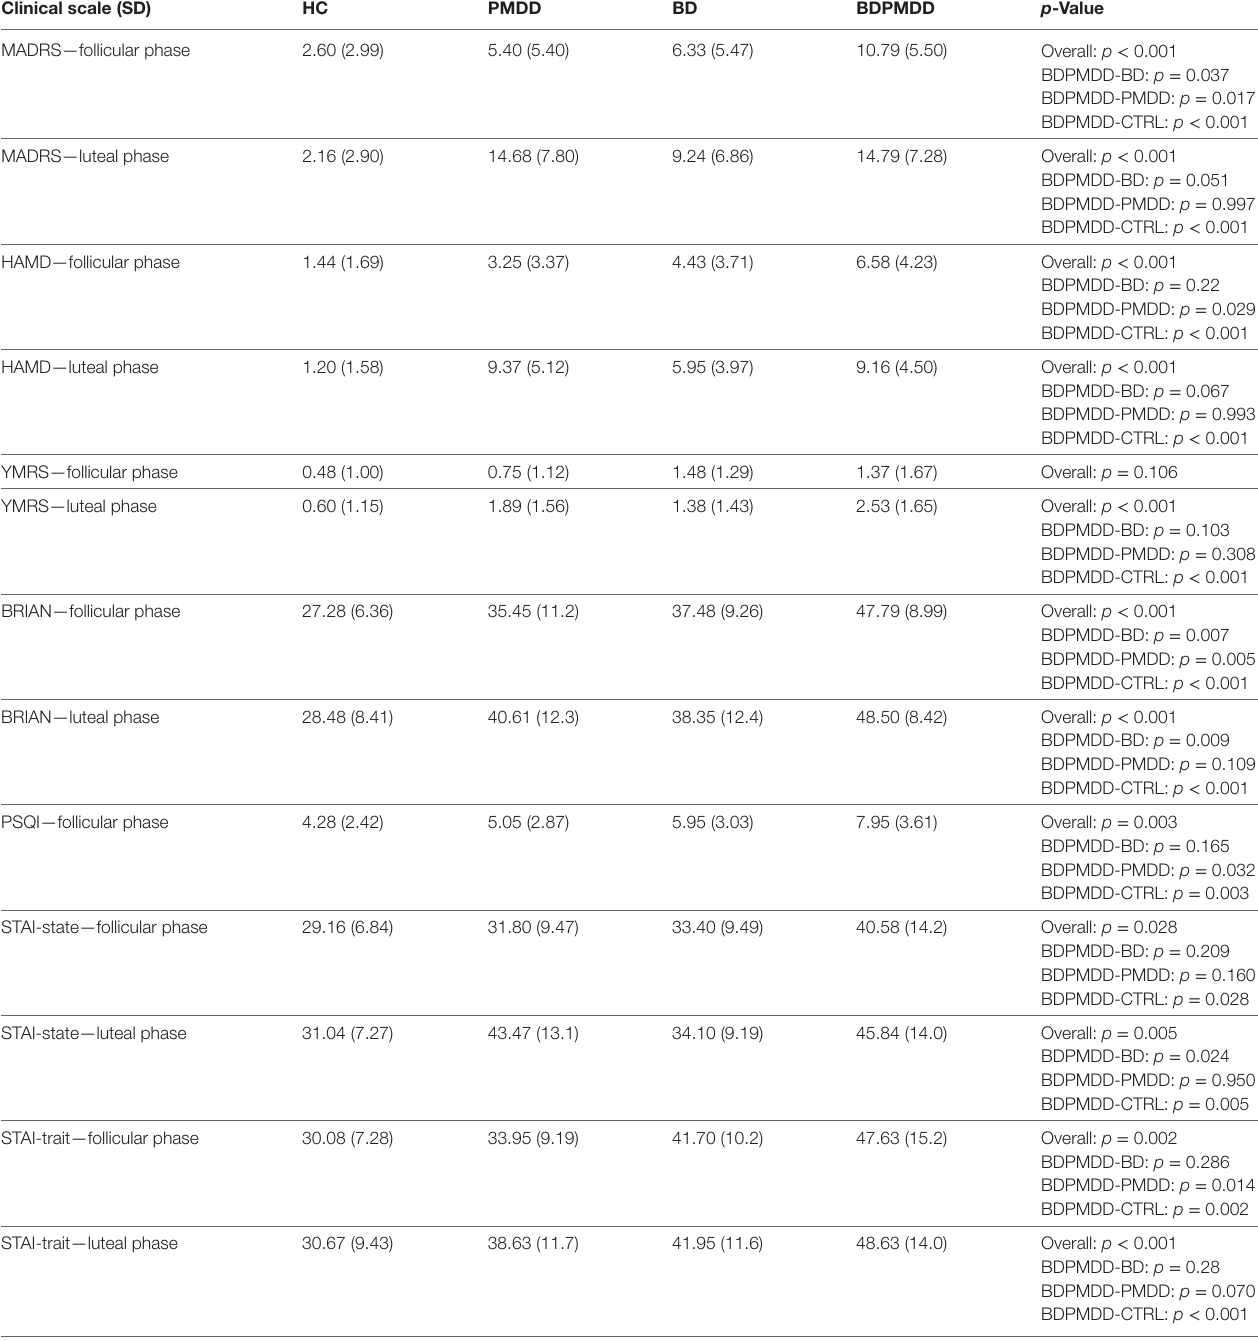
TaBle 2 | Clinical scores between